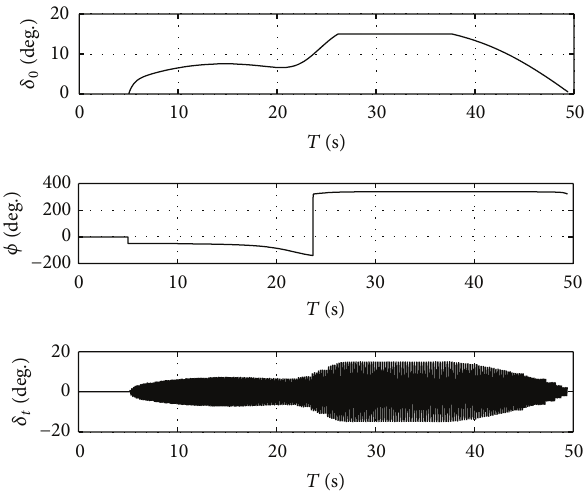
Figure 23: The deflection angle and control phase histories of the controlled trajectory with optimized trajectory correction